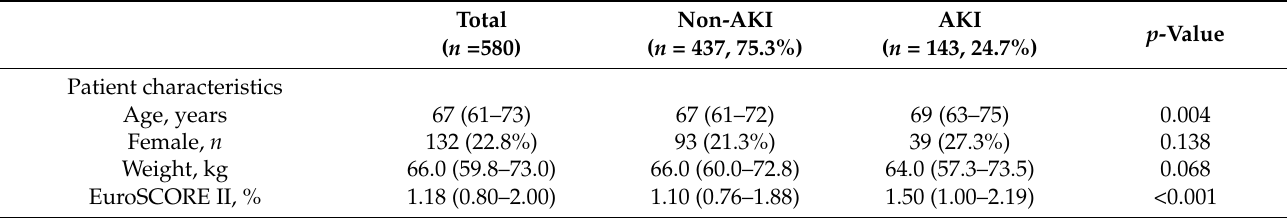
Table 1. Preoperative demographic and morphometric